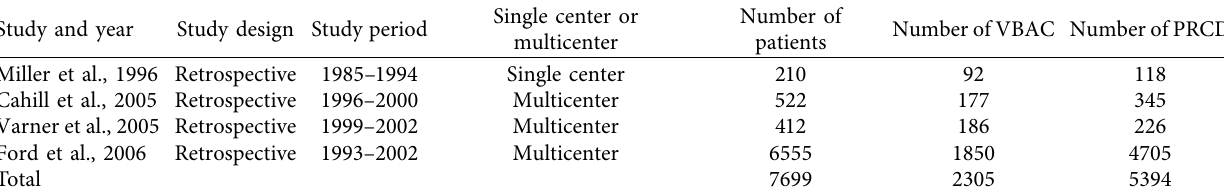
Figure 1: Study selection process. Table 1: Baseline study characteristics [31–34].